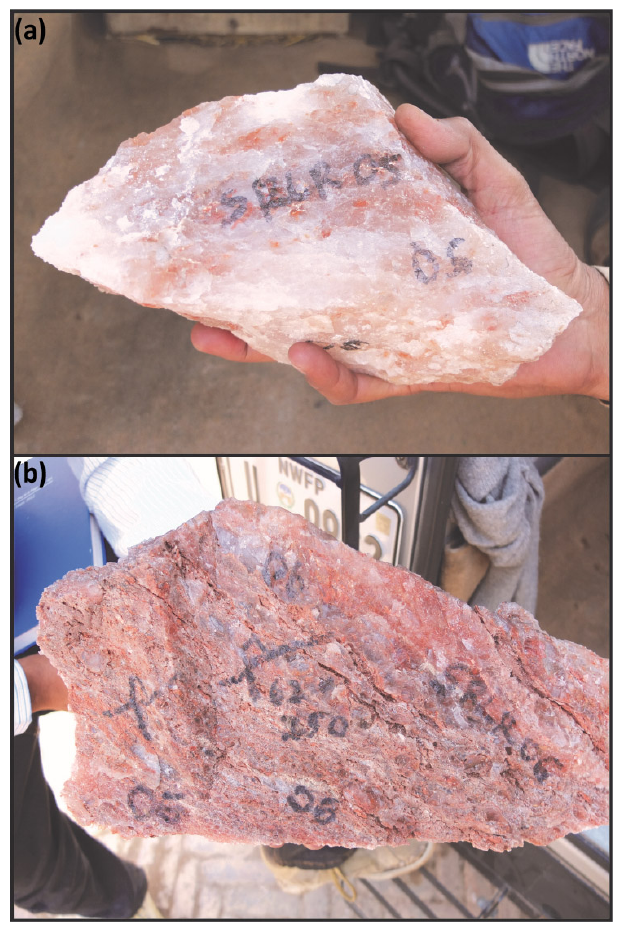
Figure 3. (a) Hand sample SRLR-05 of halite (white) with some bittern salt inclusions (orange) from Khewra Mine. (b) Hand sample SRLR-06 of potash marl (red orange) with clear to white crystalline halite from Khewra Mine. For a detailed mineralogical and struc- tural analysis of these samples the reader is directed to Richards et al.